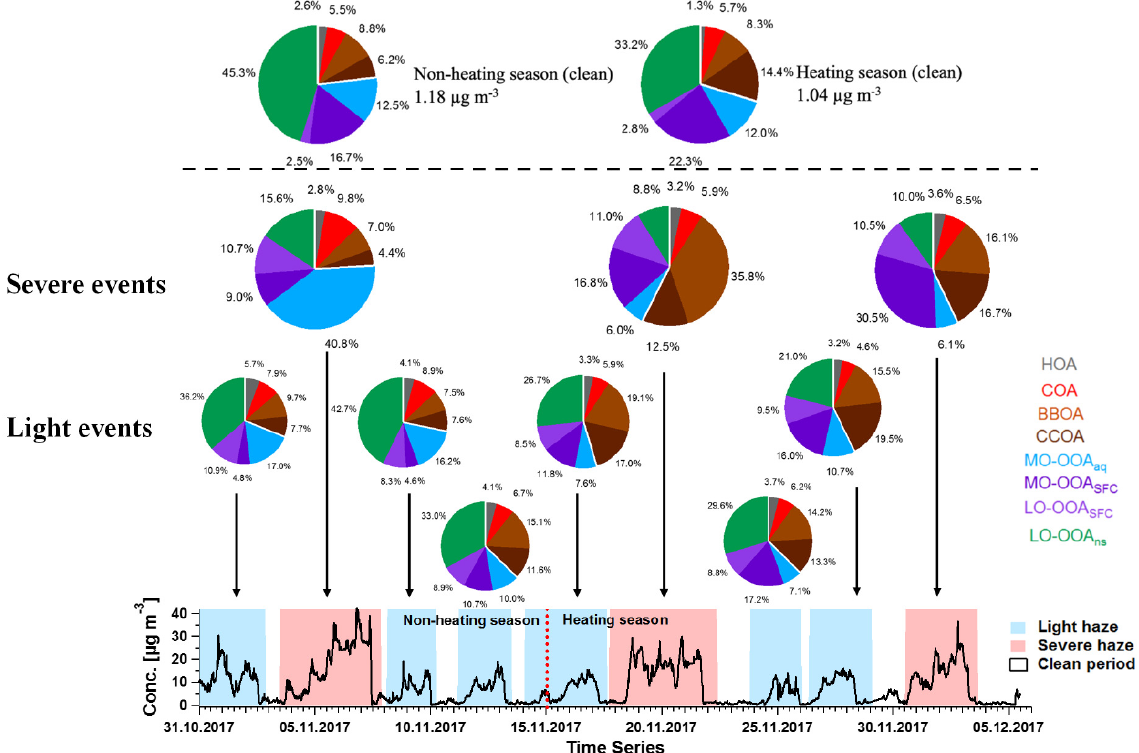
Figure 11. Time series of total OA and the mean contribution of eight AMS factors in each haze event and clean periods for the non-heating and heating periods. The top two pie charts indicate the averaged contributions for clean periods in non-heating season and heating season, and the three middle and six bottom pie charts indicate the corresponding averaged contributions for three severe haze events (red shaded area) and six light haze events (blue shaded area) according to the time series of total OA